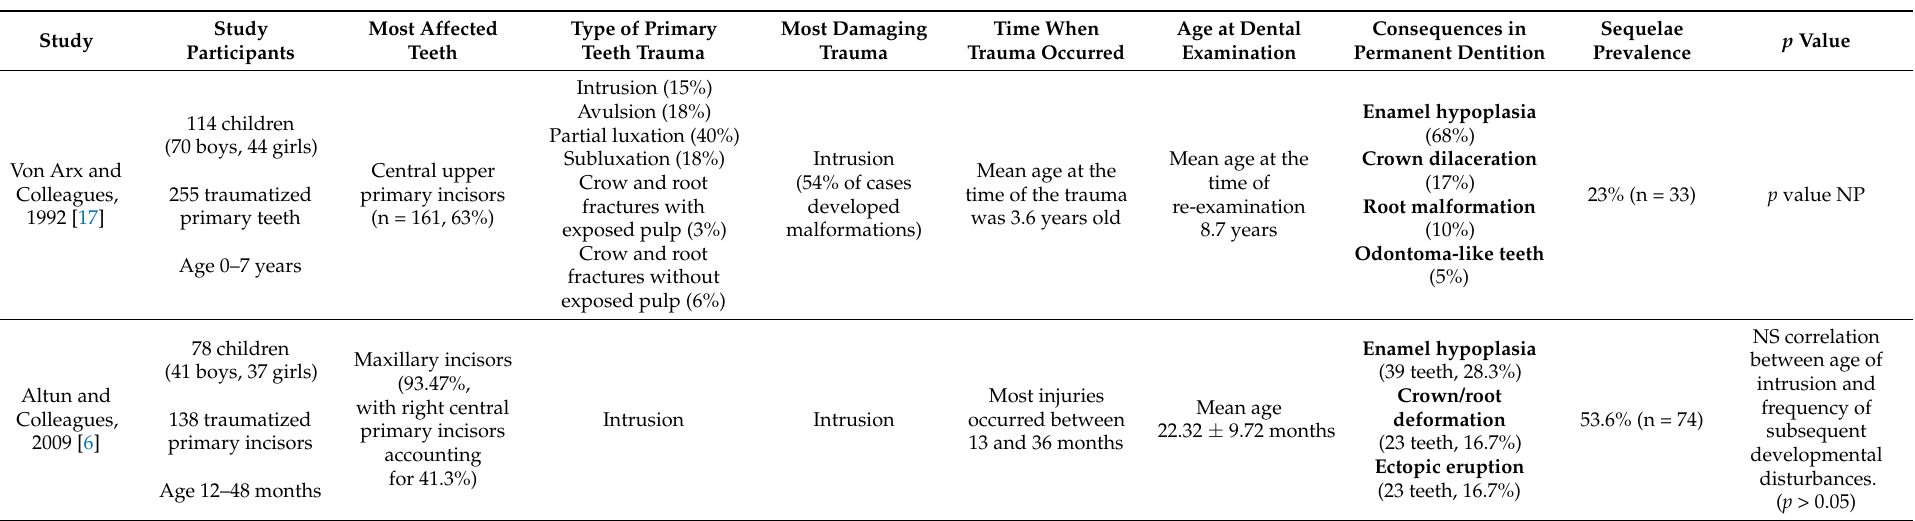
Table 3. Summary of the high-quality cohort and cross-sectional